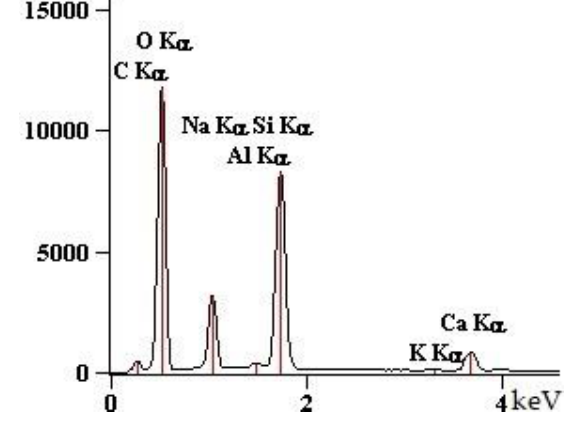
Figure 22. EDS spectrum of brick modified with 90% GS. Point 2.